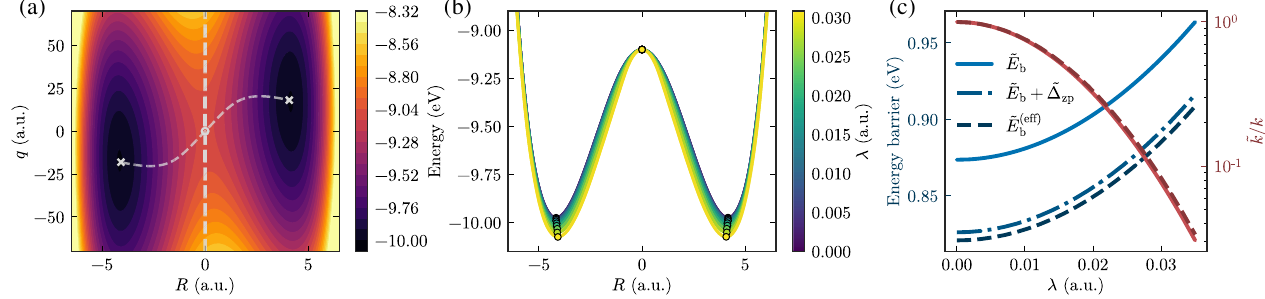
FIG. 3. (a) Two-dimensional ground-state PES in the cavity Born-Oppenheimer approximation for the Shin-Metiu model for λ ¼ 0 . 02 a : u : and ω ¼ 72 . 6 meV. At R ¼ 0 , we show the dividing surface used to compute the reaction flux from reactant to product states. c The gray dashed curve corresponds to the energy path along q different values of the Rabi frequency, which is related to the coupling strength through Ω evaluated at the minimum, as discussed in Appendix B. (c) Energy barrier and rate ratio versus the coupling strength for the case of a CBOA calculation (full lines) and for the effective energy barrier fitted from exact quantum rate calculations (dashed